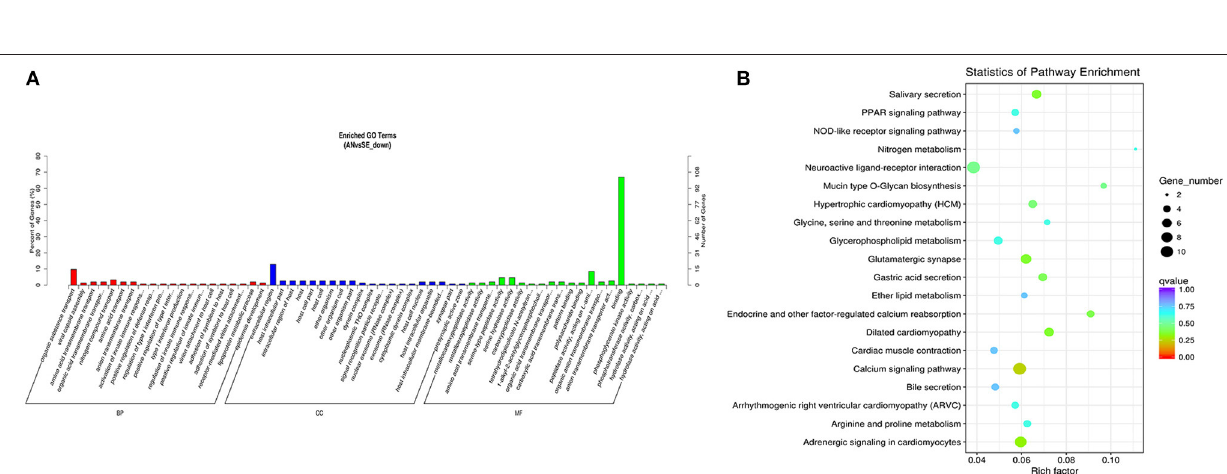
Frontiers in Veterinary Science |